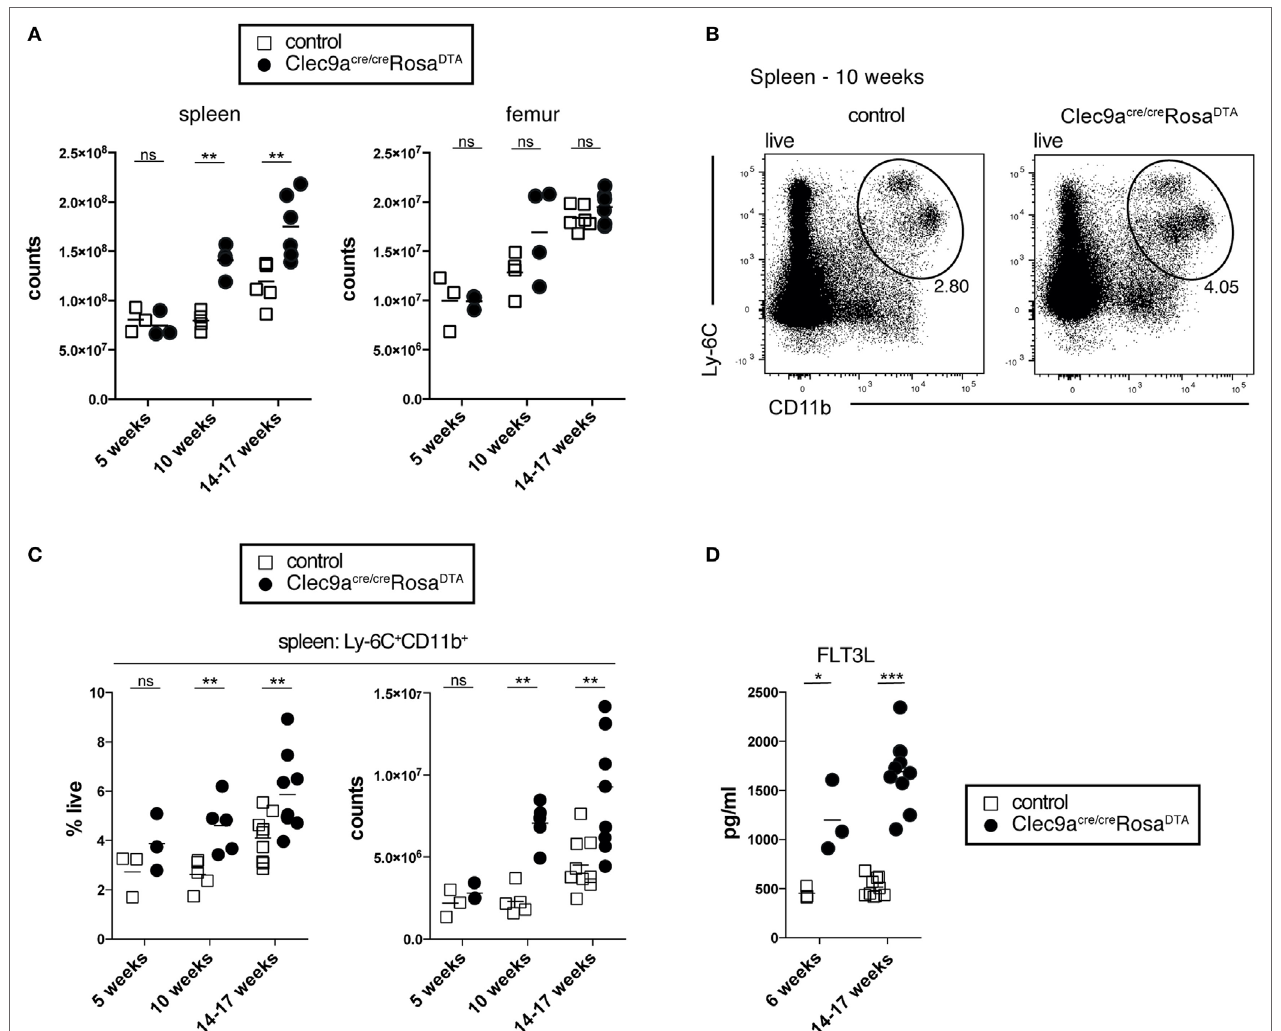
FigUre 1 | Clec9a cre/cre Rosa DTA mice showing signs of age-dependent myeloproliferation. (a) The total number of leukocytes per spleen and femur from control and Clec9a cre/cre Rosa DTA mice of the indicated ages is shown. (B,c) Ly-6C + CD11b + cells were identified by flow cytometry in spleen from control and Clec9a cre/cre Rosa DTA mice. (B) Representative gating strategy of Ly-6C + CD11b + cells in 10-week-old mice. Plots are gated on DAPI − live cells. (c) Frequency and total counts of Ly-6C + CD11b + cells in mice of the indicated ages and genotypes. (D) Serum was collected from control and Clec9a cre/cre Rosa DTA mice at 6 and 14–17 weeks of age and the concentrations of FLT3L were determined by ELISA. Each symbol represents one mouse. ns, not significant; * p < 0.05, ** p < 0.001, and *** p <